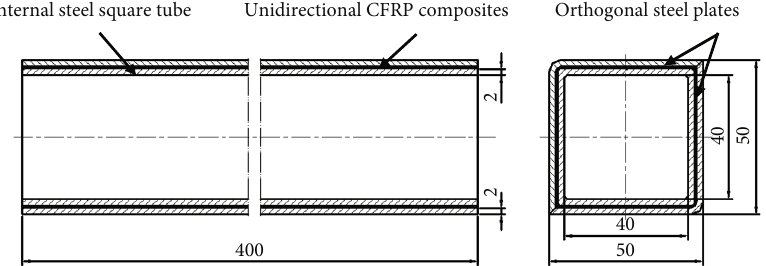
Figure 3: Dimensions of the hybrid HST with sandwich